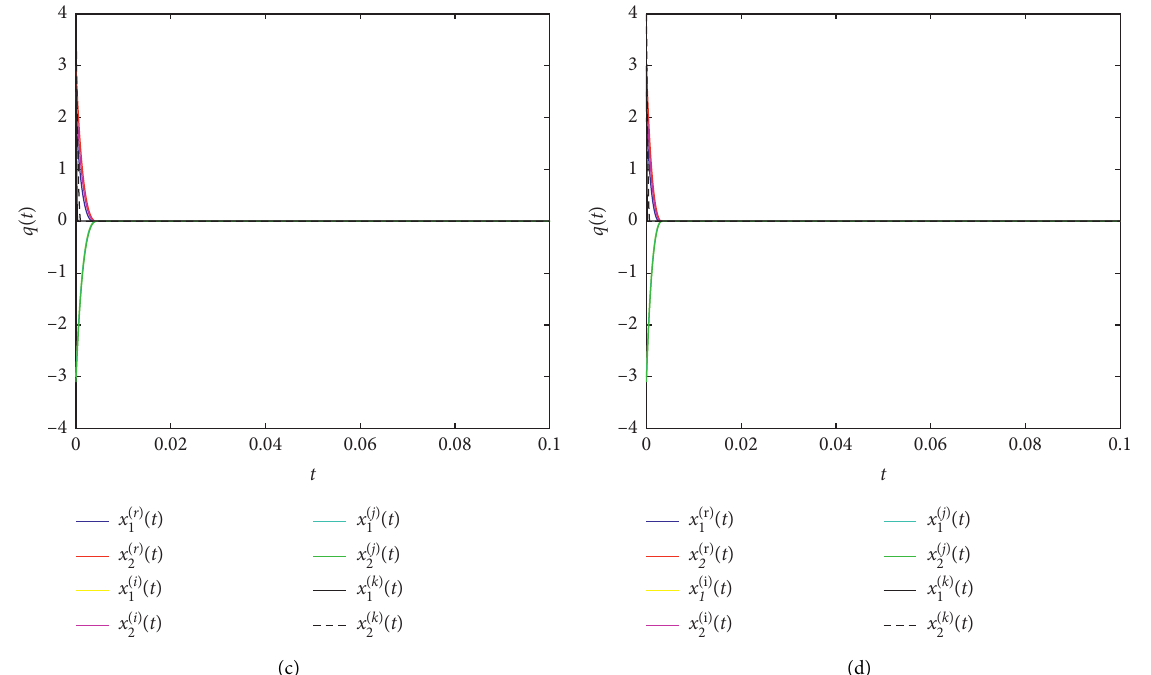
Figure 2: Effect of the change of Λ � 750 × E. (d) Λ 2